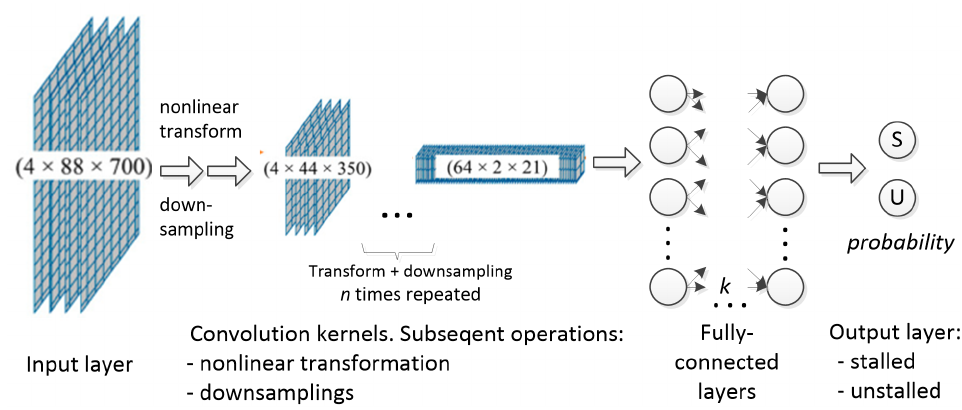
Figure 8. Structure of the CNN for identification of stall flow patterns in pump turbines by [22]. Table 2. Parameters of neural networks designed for identification.